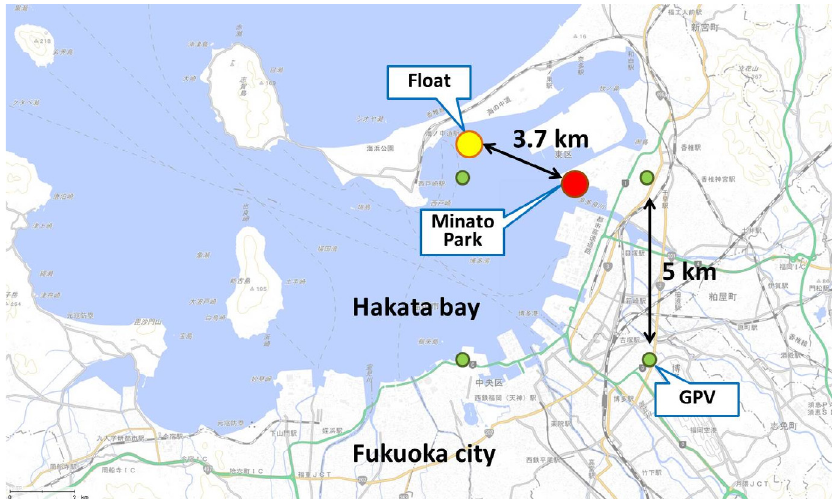
Fig. 6. Mooring location of the platform for the Hakata-Bay experiment. There is a bay side park called “ Minato Park ” on the adjacent shore, 3.7 km away from the